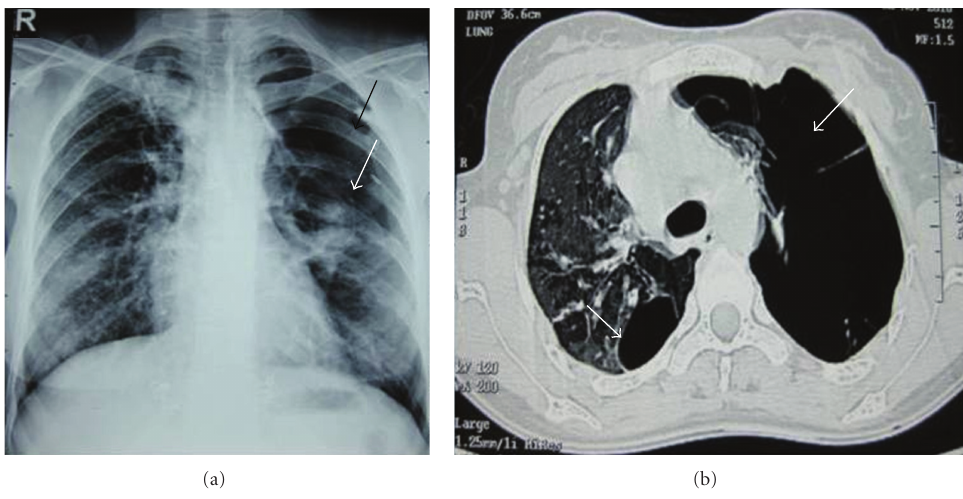
Figure 2: Chest X-ray (a) in the Emergency Department showing pneumothorax of left side (black arrow) with collapsed visceral pleural line (white arrow) and corresponding computed tomography of thorax (b) showing massive pneumothorax of left side (white arrow) with infiltrates and cystic space (white arrow) in right upper lobe.